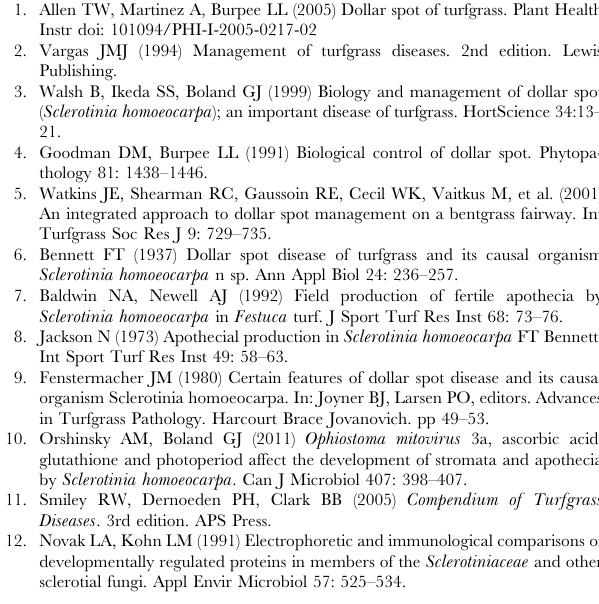
Figure S3 Q-PCR for molecular detection of Sclerotinia homoeocarpa DNA in creeping bentgrass commercial seed lots. A , Standard curve of EF1 a plasmid DNA with the primer set EF1 a _NestF/EF1 a _NestR indicating near 100% primer efficiency. B , Q-PCR run with various controls to reveal the presence of PCR inhibitors: Spike, Spike 2 1 , Spike 2 2 —Ten- fold dilution series of seed DNA mixed with 1/10 volume EF1 a plasmid DNA at a starting concentration 1 6 10 6 .; Check, Check 2 1 , Check 2 2 —Ten-fold dilution series of a seed DNA sample positive by nested PCR but negative by Q-PCR.